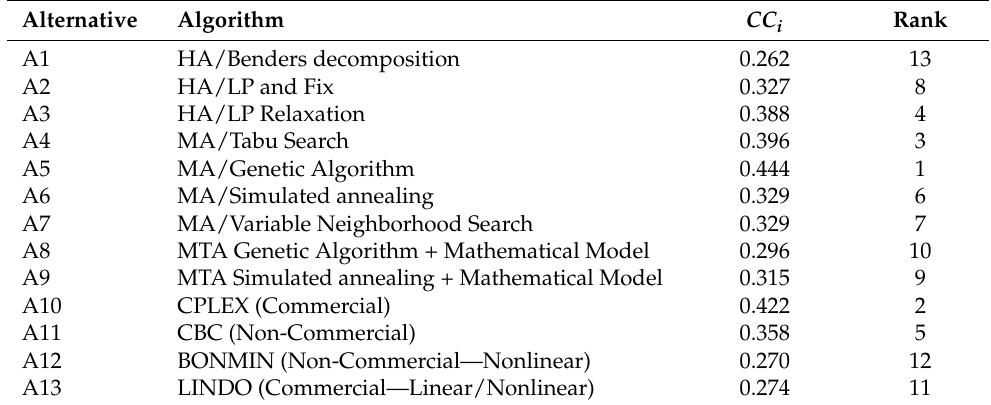
Table 8. Closeness quotient and algorithms